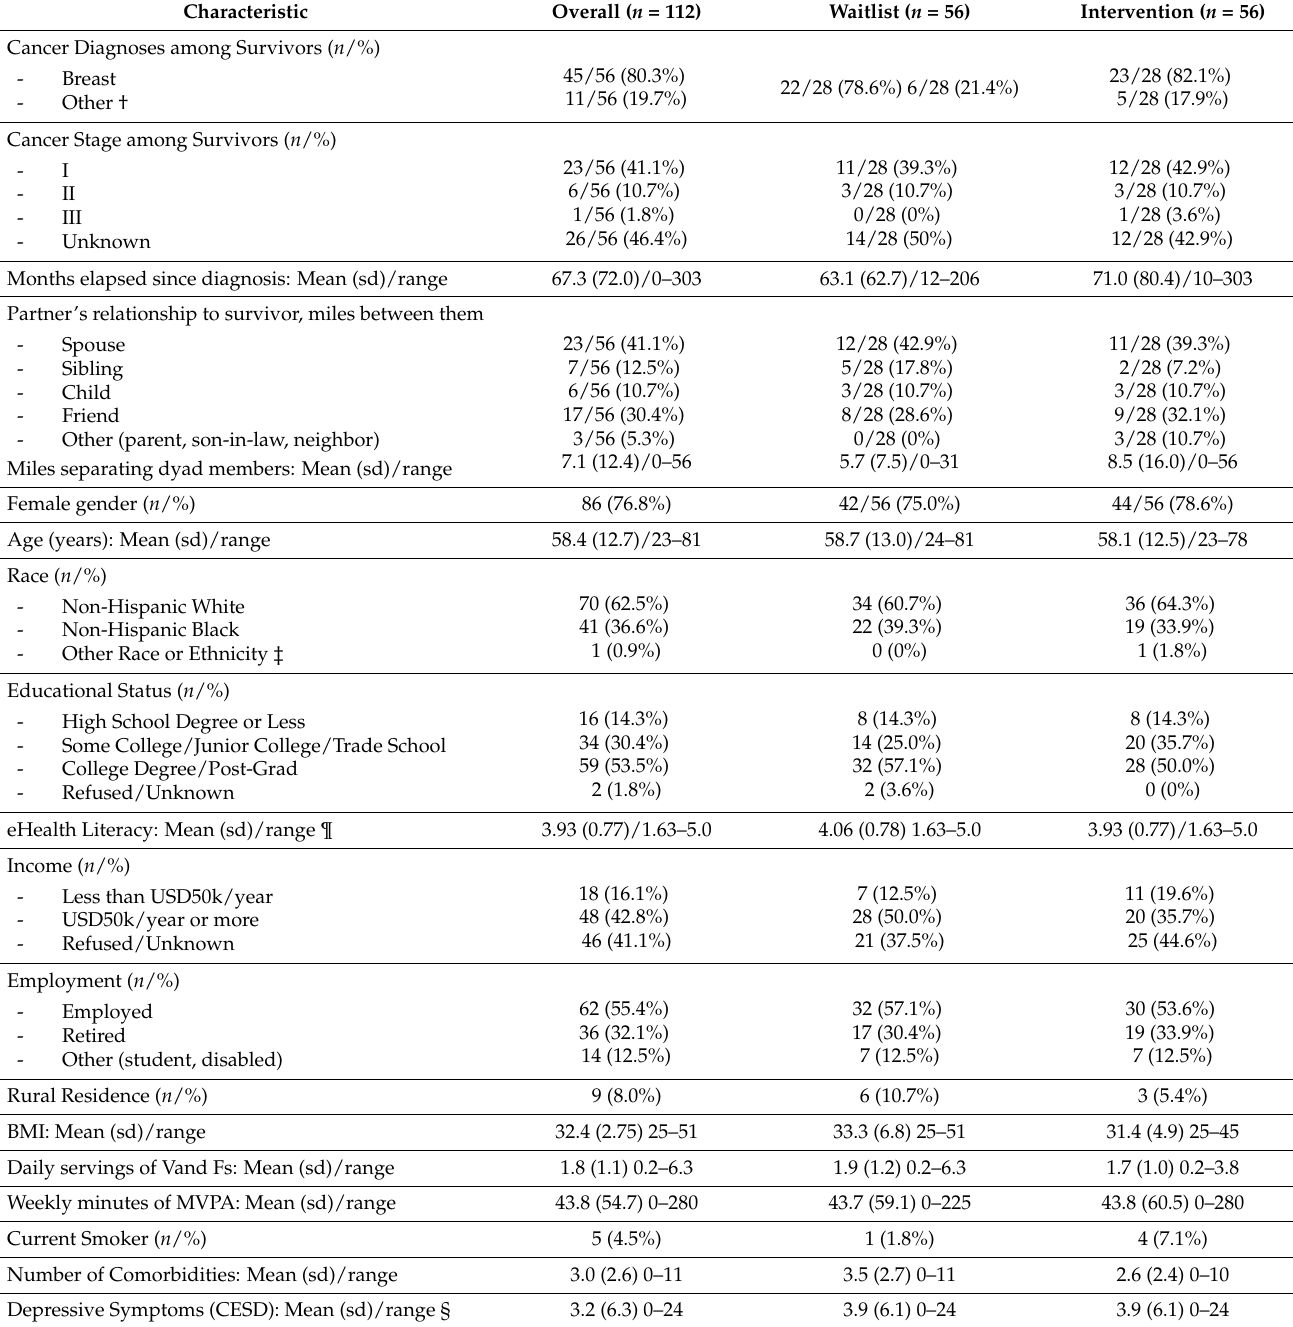
Table 1. Characteristics of DUET study participants overall and by arm *.